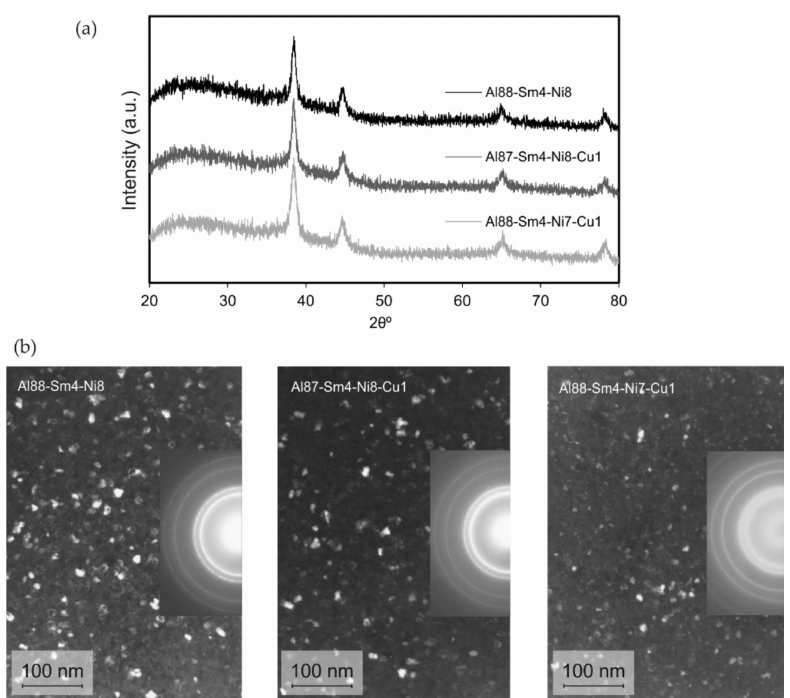
Figure 3. Study of the first DSC reaction of Sm alloys after heating at 20 ◦ C / min to 250 ◦ C and immediate cooling: ( a ) XRD patterns of ribbons, with peaks corresponding to α -Al nanocrystals, and ( b ) transmission electron microscopy (TEM) dark field images and di ff raction patterns